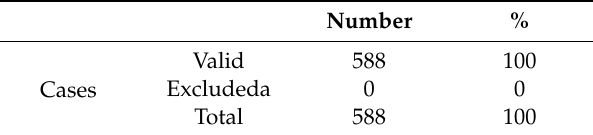
Table 3. Validity